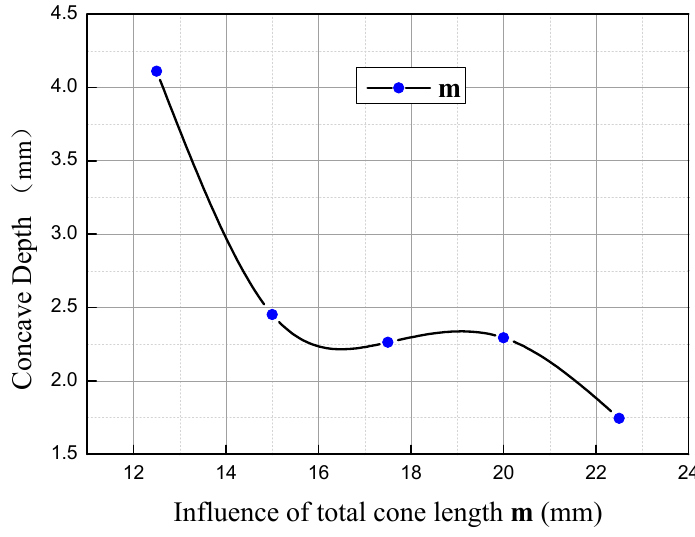
Figure 11. Influence of total cone length m on concave depth.